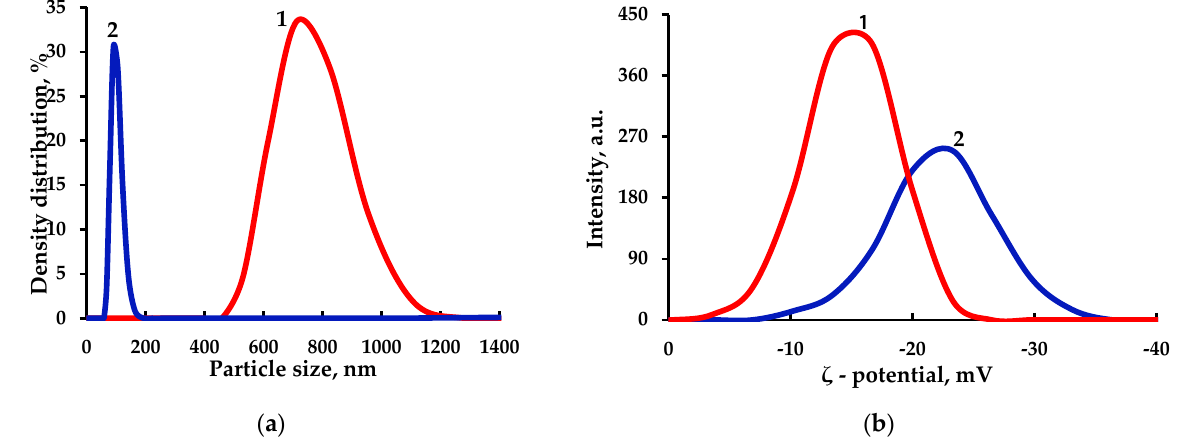
Figure 9. Hydrodynamic particle diameter ( a ) and ζ -potential of suspended particles ( b ) of nanocellulose samples 1 – MCC and 2 – MFC.